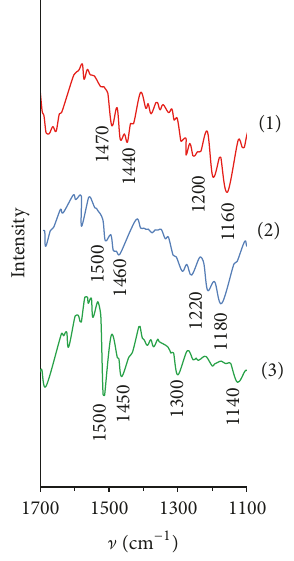
Figure 2: IR spectra of PVP-gr-PMMA copolymers depending on the ratio of components in the synthesis and the drying temperature of the copolymer: MMA: PVP in the synthesis of the copolymer, mol/mol monomer concentration: (1) , (2) 3:1; (3) 1:1. 𝑇 𝑑 , 𝐾 : (1) 313; (2) , (3)